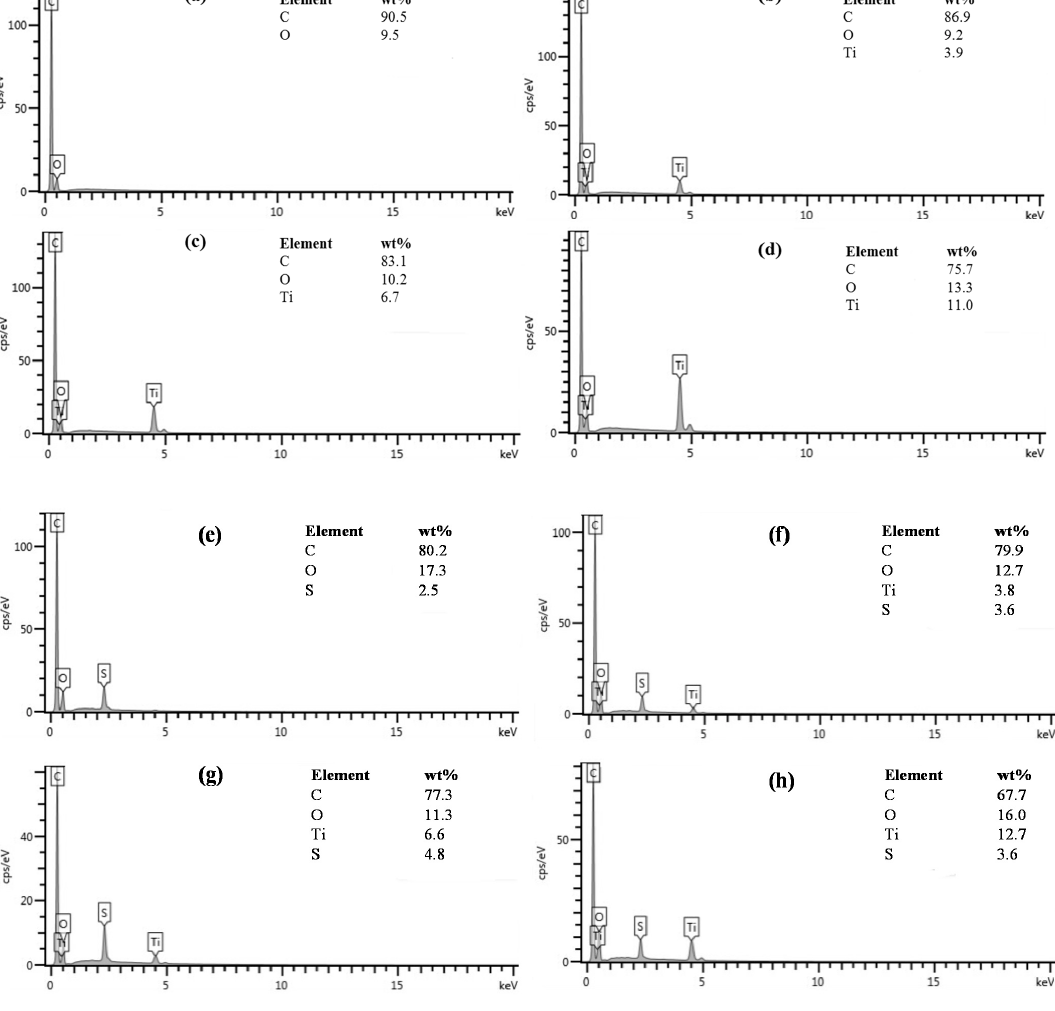
Figure 3. EDS spectra and elemental composition of ( a ) neat C, ( b ) neat 1%TiO 2 C, ( c ) neat 5% TiO 2 C, ( d ) neat 10% TiO 2 C, ( e ) C_S solid acid catalyst, ( f ) 1%TiO 2 C_S solid acid catalyst, ( g ) 5% TiO 2 C_S